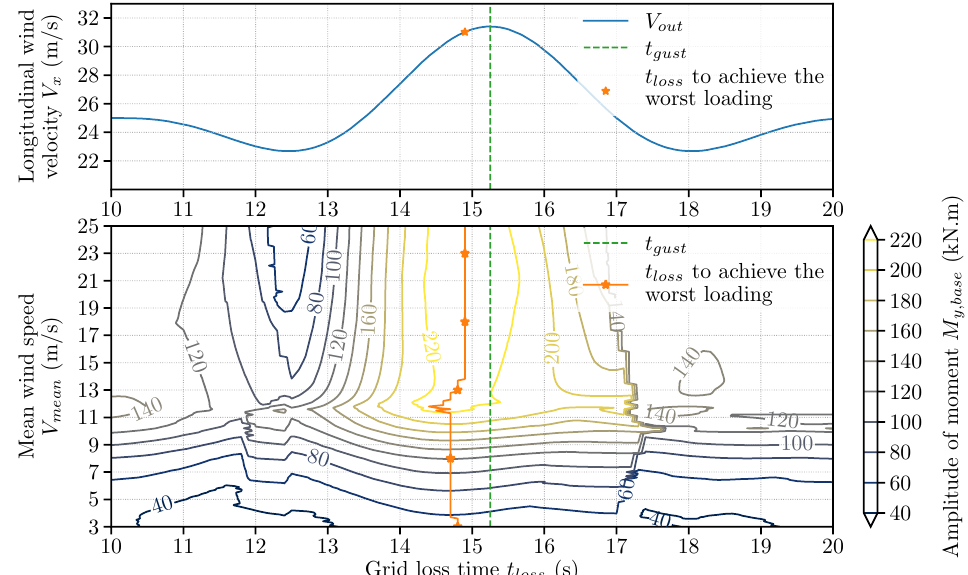
Figure A2. Grid loss timing in the range of operating wind speed with reference to tower moment. The upper line plot gives an example of wind speed of gust at mean wind speed V mean = V out = 25m/s. The lower contour plot shows the peak-to-peak amplitude in relation to the mean wind speed V mean and the grid loss time t loss